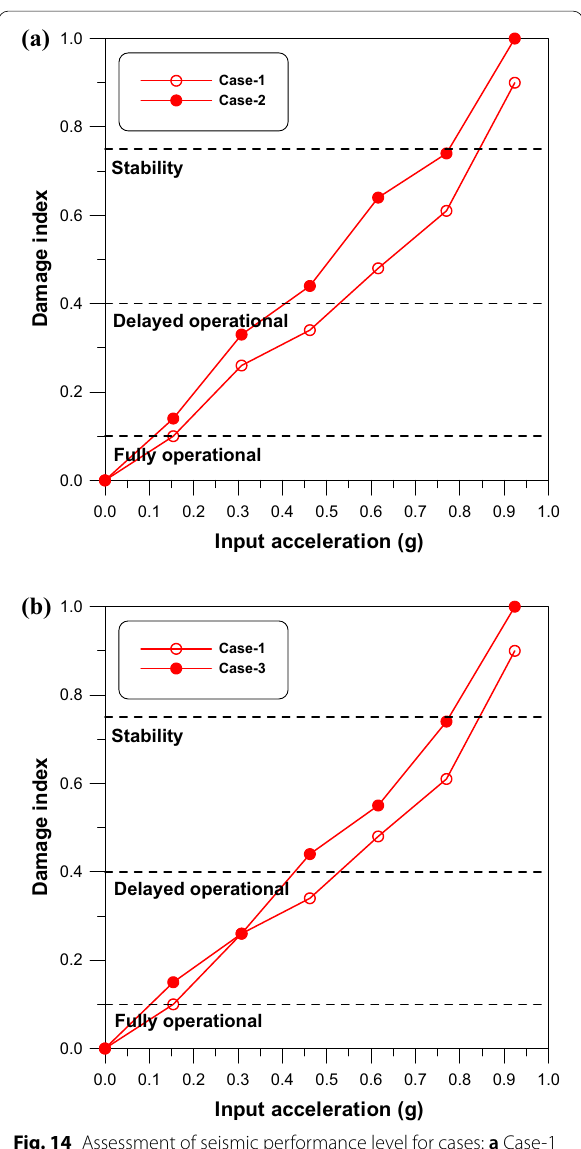
Fig. 14 Assessment of seismic performance level for cases: a Case‑1 and Case‑2 and b Case‑1 and Case‑3.